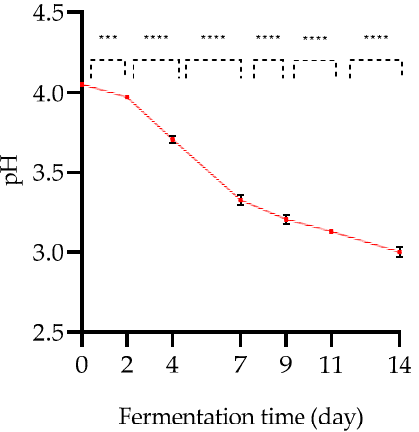
Figure 1. pH evolution of kombucha samples as a function of the fermentation time (day) at 30 °C (mean ± SD; n = 3; Student’s t -test; ****, p < 0.0001; ***).